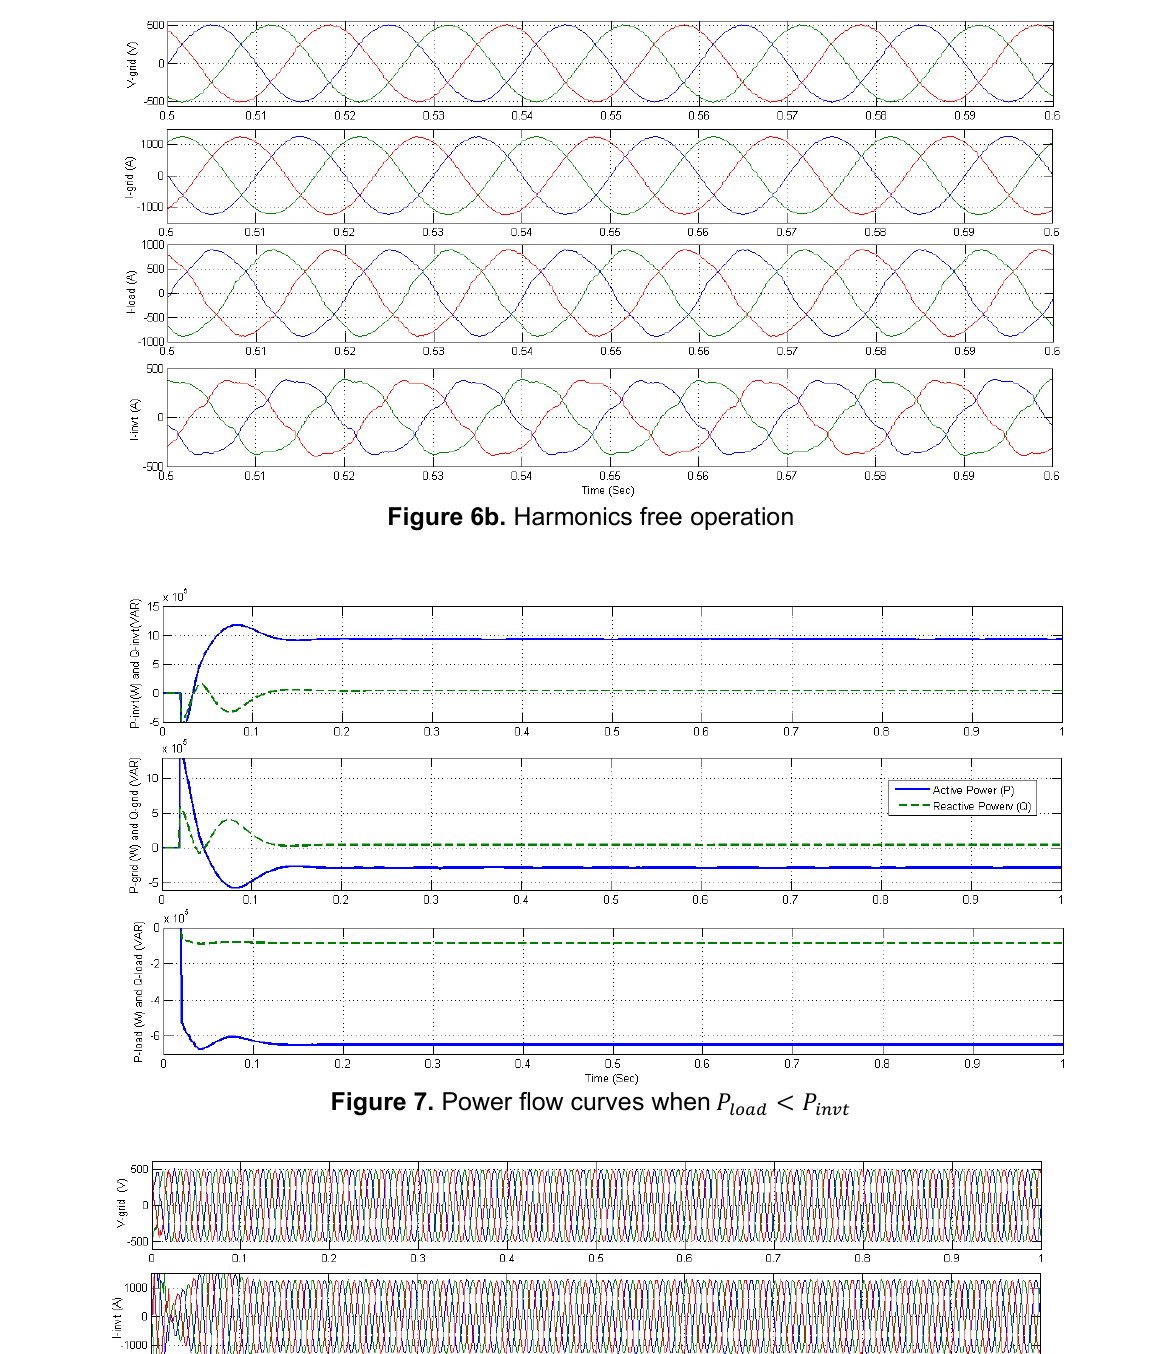
𝑃𝑃 𝑙𝑙𝑙𝑙𝑙𝑙𝑙𝑙 < 𝑃𝑃 𝑖𝑖𝑖𝑖𝑖𝑖𝑖𝑖